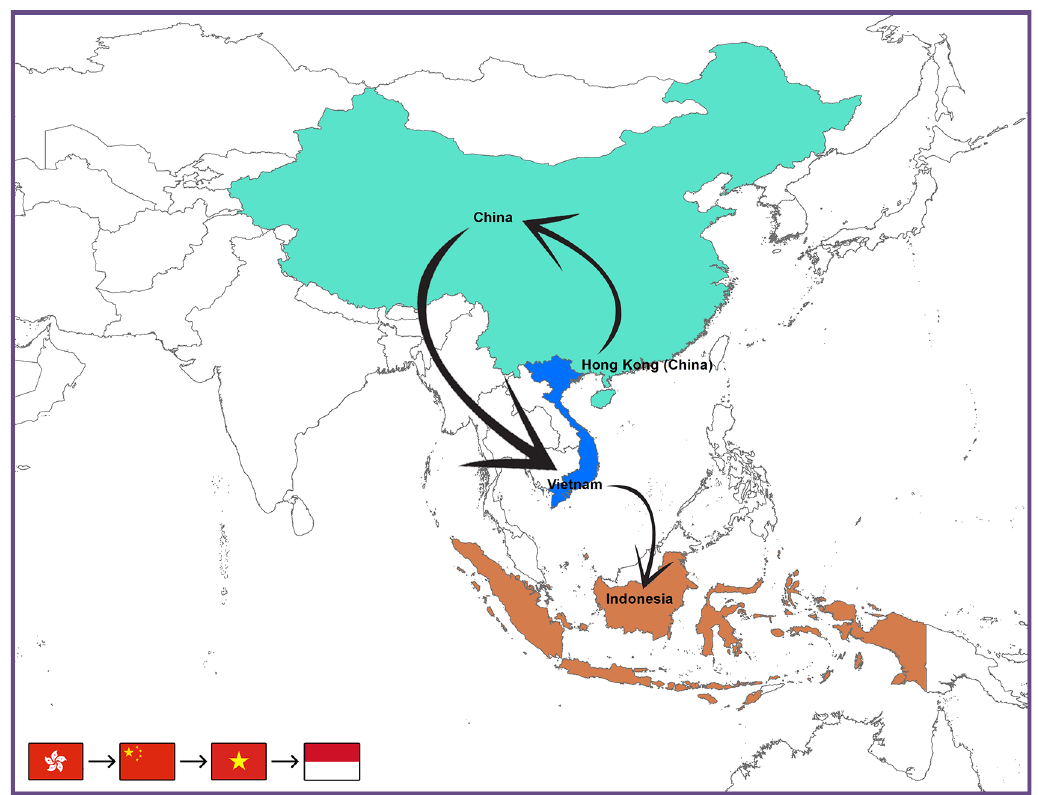
Figure 2. Map depicts the proposed and hypothesized pathways of the avian influenza H9N2 virus taken from Hong Kong to Indonesia.